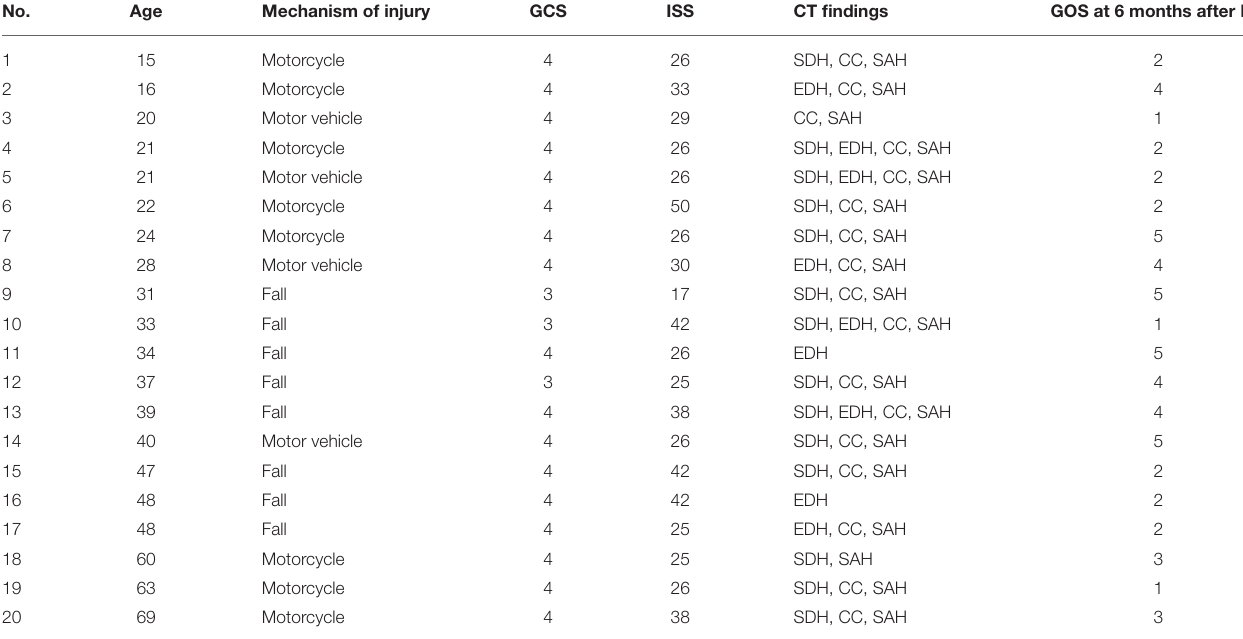
TABLE 3 | Clinical and radiological characteristics of survival patients with GCS < 5 and bilateral dilated pupils before DC. No. GCS ISS CT findings